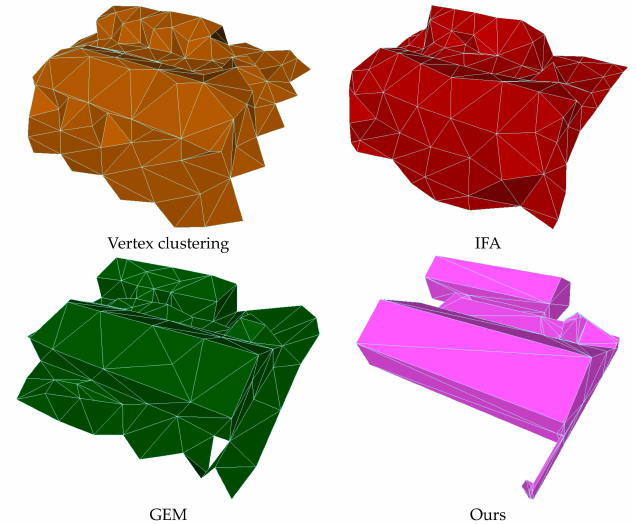
Figure 12. Comparison with the mesh element decimation method [16–18].